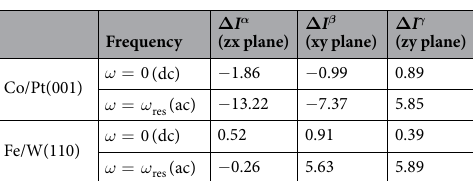
5.89 for applied dc and resonant electric fields for the , ,